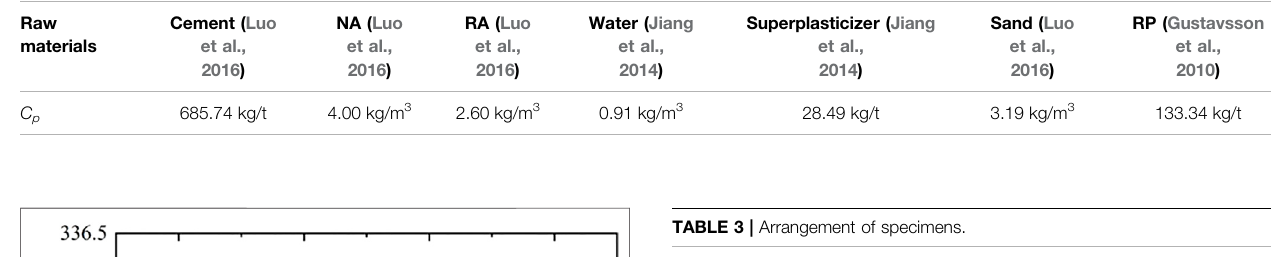
TABLE 2 | Cp of each type of raw materials for RRAC.